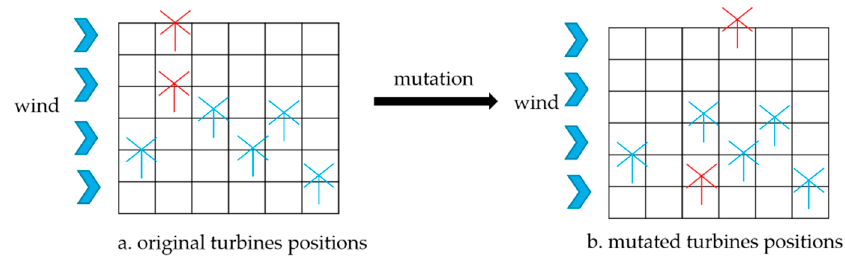
Figure 3. Schematic diagram of the mutations in a 6 × 6 matrix.